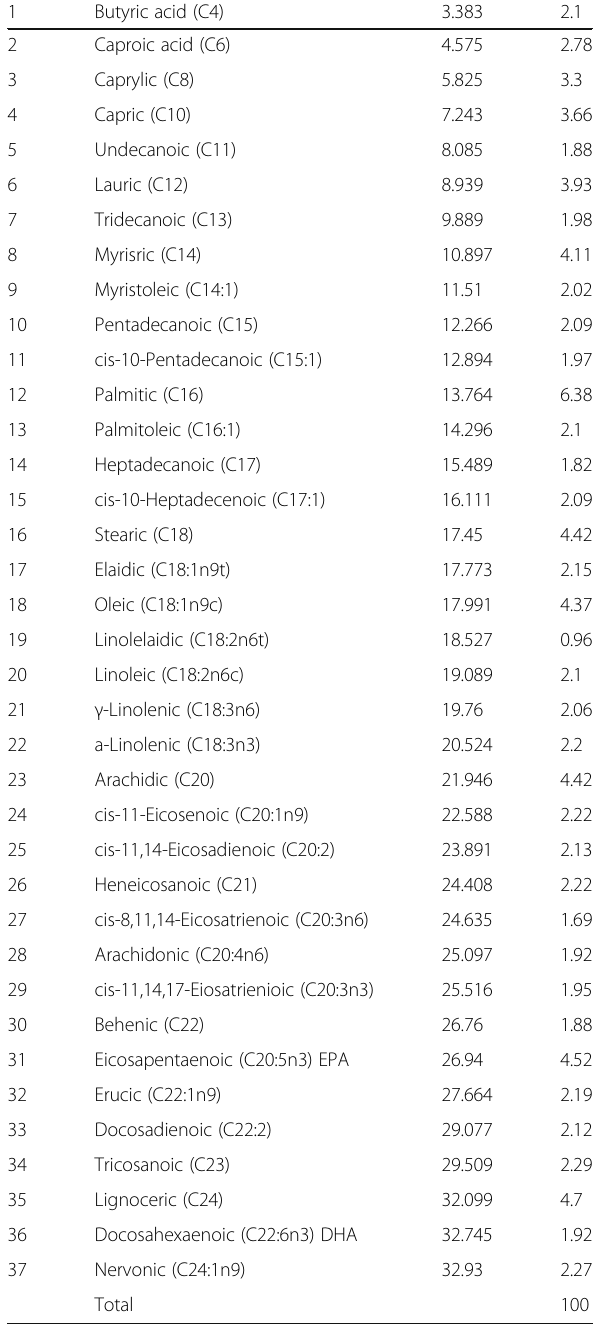
Table 6 List of targeted fatty acids in GC-FID